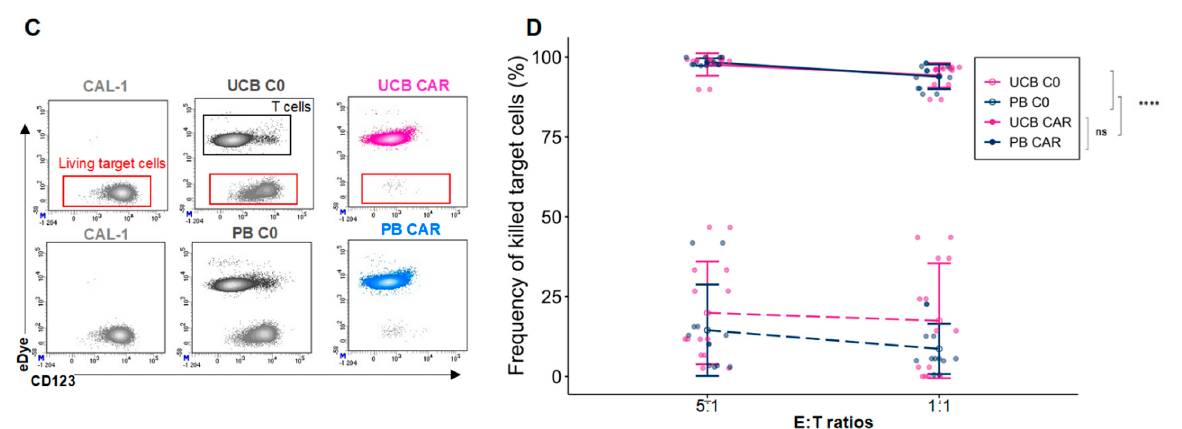
Figure 3. In vitro functionality of fresh UCB CAR-T. ( A ) Examples of intracellular staining of IL-2 in CD3+T cells. ( B ) Frequency of intracellular IL-2 and IFN- γ positive cells after 15 h of co-culturing T cells with CAL-1 cells at an E:T of 1:1 ( n = 4). UCB (pink), PB (blue). ( C ) Cytotoxicity of CAR-T cells. Examples of a representative experiment to determine the cytotoxicity of target cells (CAL-1). Living target cells were defined as CD123+/Edye-/7AAD- (red boxes). eDye positive T cells are in black boxes. CAL-1: the CAL-1 line alone. UCB C0: CAL-1 plus UCB-C0. UCB CAR-T: CAL-1 plus UCB-CAR-T. ( D ) Levels of cytotoxicity after 24 h of co-culturing (5:1 and 1:1 E:T ratio) ( n = 8 for UCB and n = 7 for PB). UCB: Umbilical Cord Blood, PB: Peripheral Blood. ns: non-significant, * p < 0.05, ** p < 0.01, *** p < 0.001, **** p <